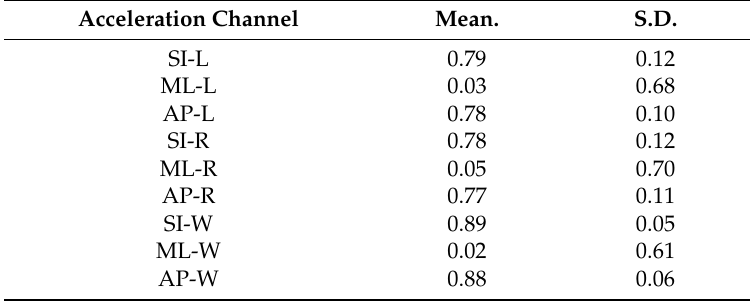
Table 3. Correlation coefficients of the 3 × 3 channels acceleration in the AD group.